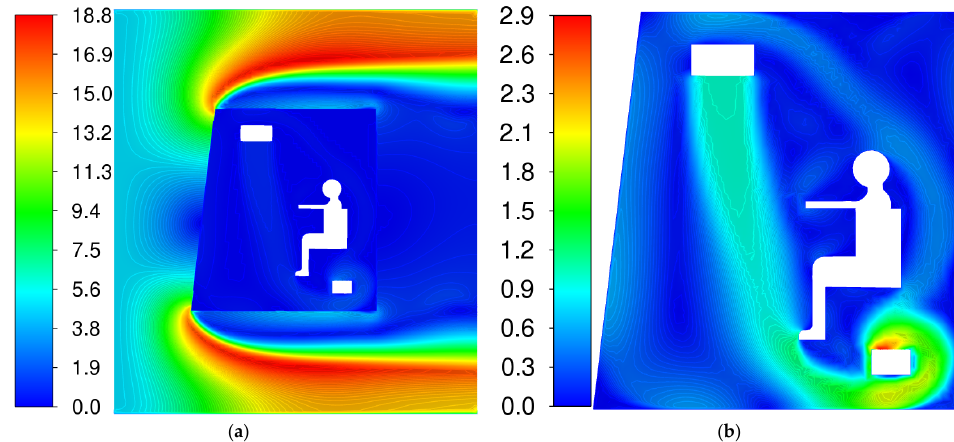
Figure 5. Velocity field, m/s: ( a ) in all domains; ( b ) in the cabin.